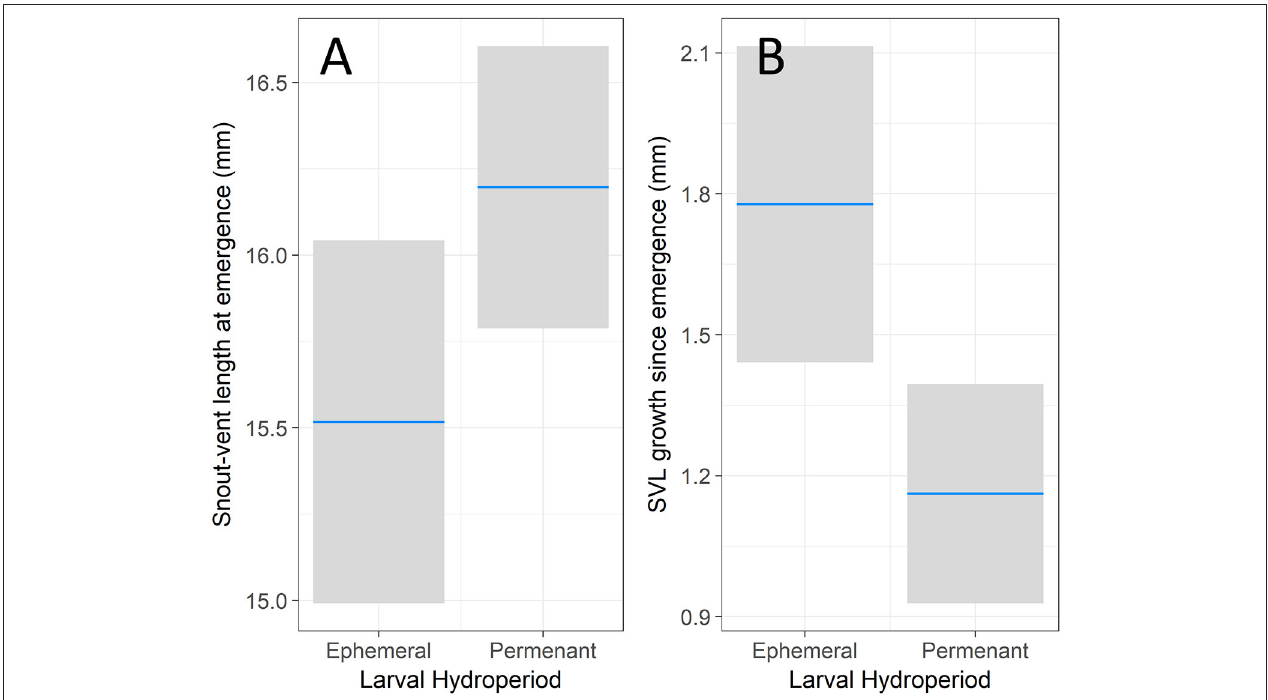
FIGURE 1 | The effect of hydroperiod on snout-vent length. The left (A) shows the effect of hydroperiod on emergence SVL after controlling for the emergence day. The right (B) shows the effect of hydroperiod on juvenile SVL growth during the first assay after controlling for emergence day, days since emergence, enclosure density. The blue bar represents the modeled response of an average individual with the 95% confidence interval in the shaded